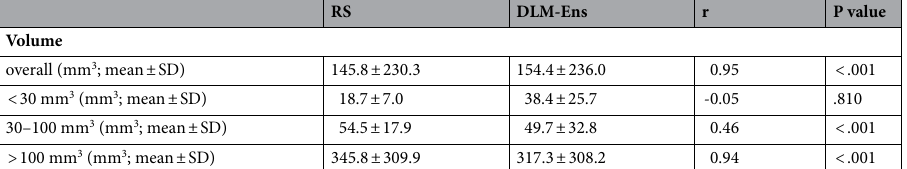
RS DLM-Ens r P value